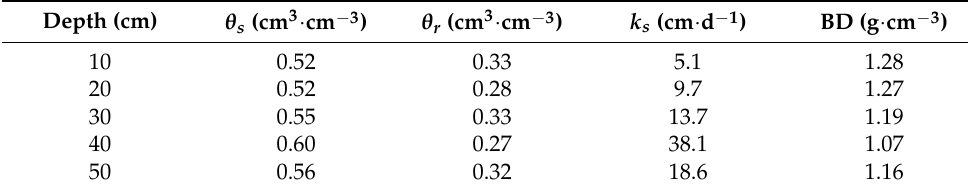
Table 3. Soil textural and soil hydraulic parameters. Depth